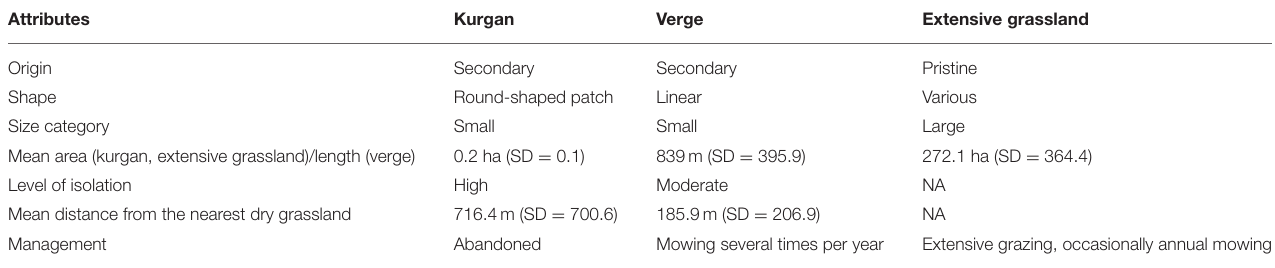
TABLE 1 | Main attributes of the studied grassland habitats.